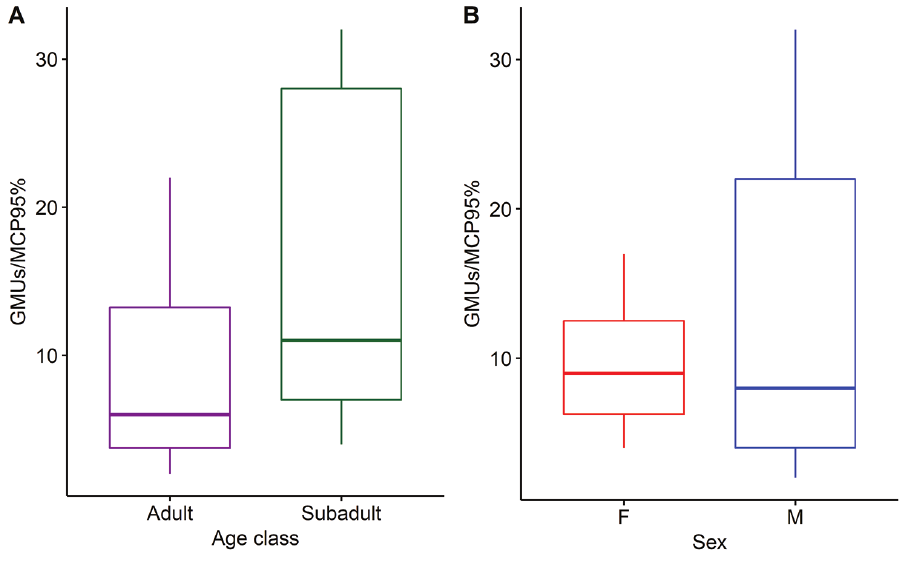
Figure 4. Number of Game Management Units (GMUs) overlaping subadults/adults bears ( A ) and females/males ( B ) MCP95% annual home ranges in Eastern Romanian Carpathians and Subcarpathians (box = interquartile range, horizontal line = median, whiskers = 1.5 × interquartile range).